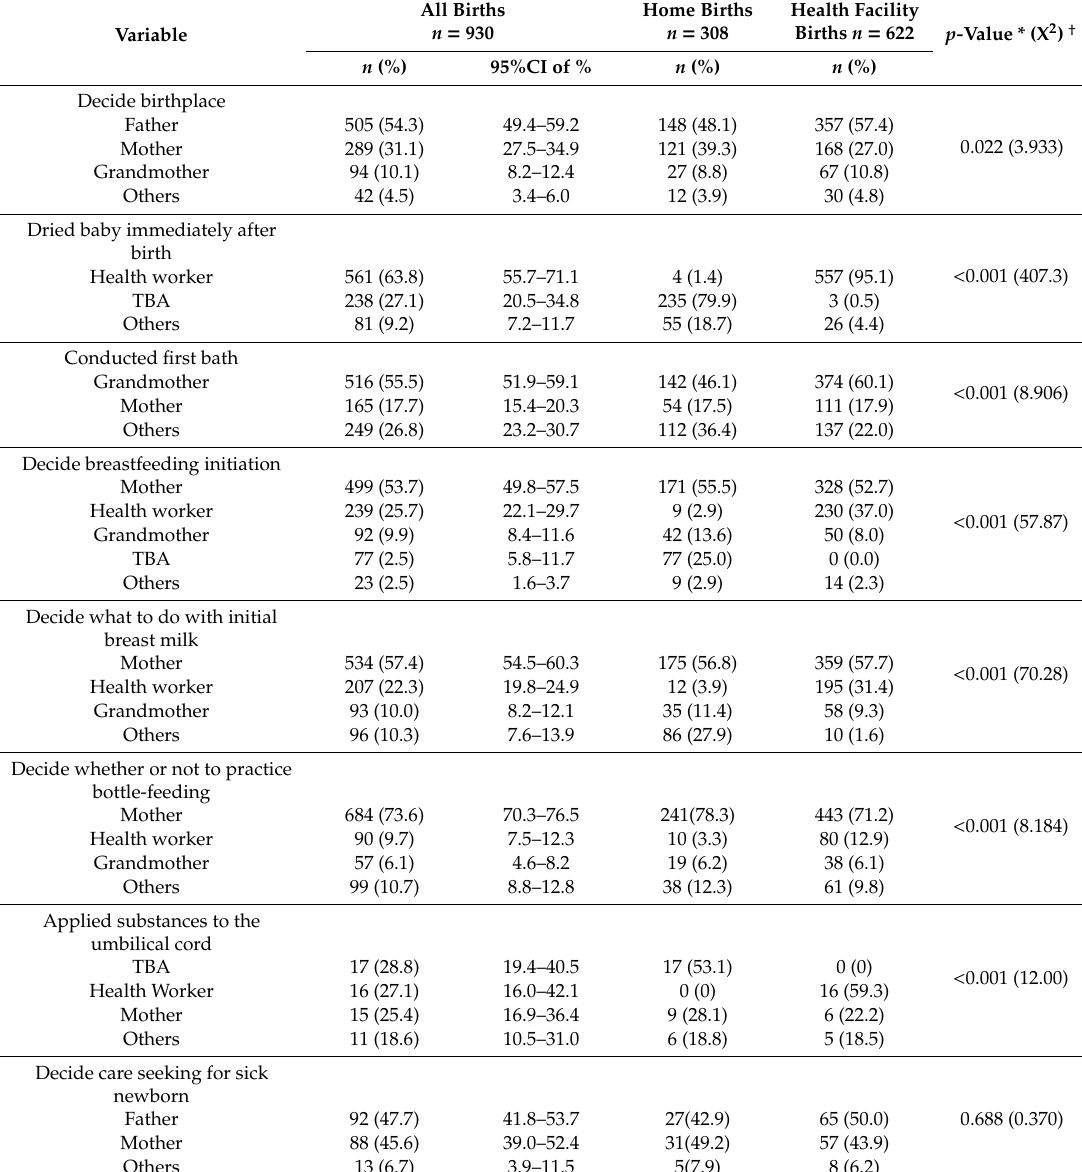
Table 2. Table showing key decision makers and actors in newborn care in the Lira district, Northern